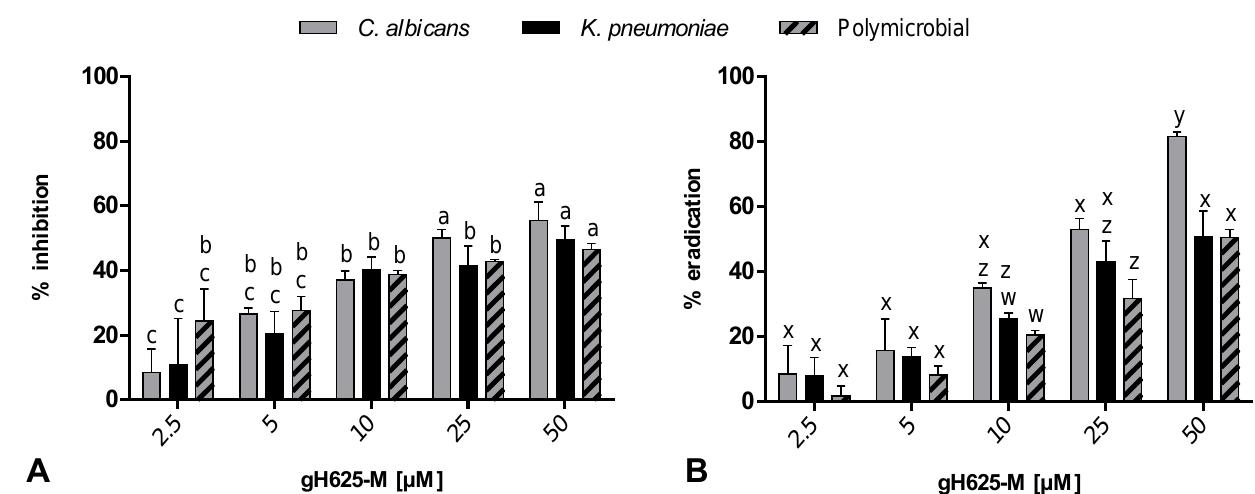
Figure 3. Action of increasing gH625-M concentrations on inhibition ( A ) and eradication ( B ) of mono- and polymicrobial biofilms. Quantification of the residual biofilm biomass was performed by crystal violet staining. Data with different letters (a–c; w–z) are significantly different (Tukey’s, p < 0.05).